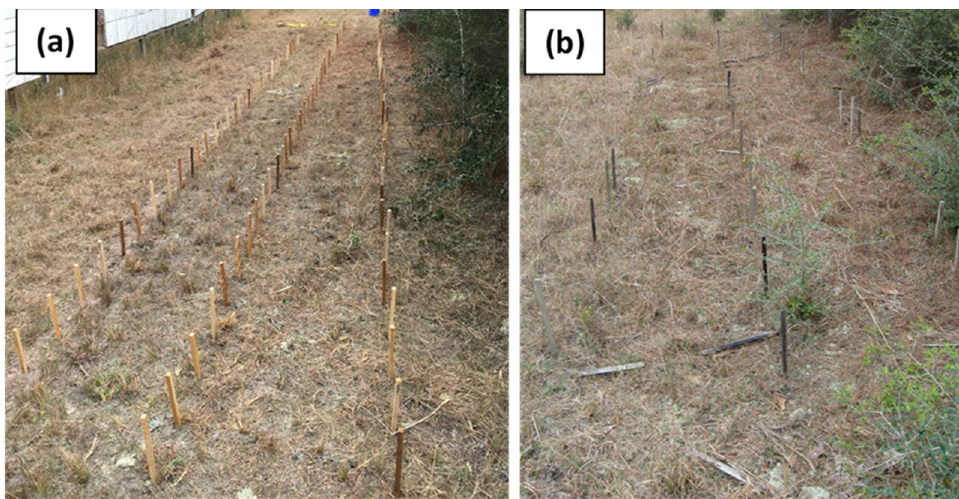
Figure 2. Example of array in AWPA E7 field stake ground contact test after installation in Novem- ber 2015 ( a ) and after five years of exposure, showing treated and untreated samples in poor condi- tions ( b ).